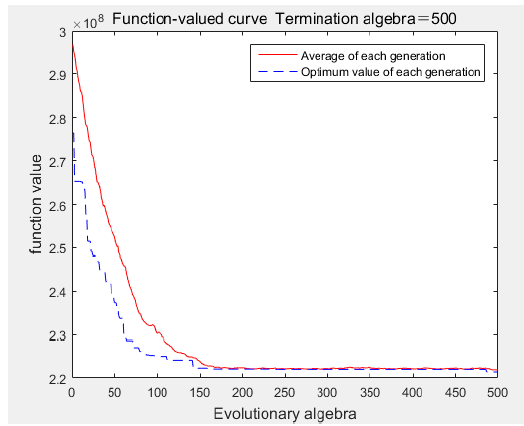
Figure 5. Evolution process of the solution.